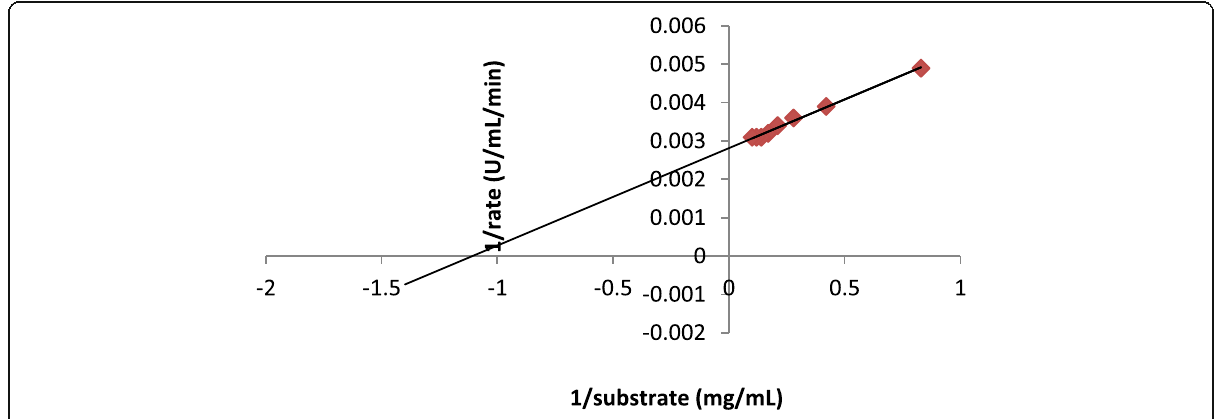
Fig. 9 Lineweaver-Burk plot of purified